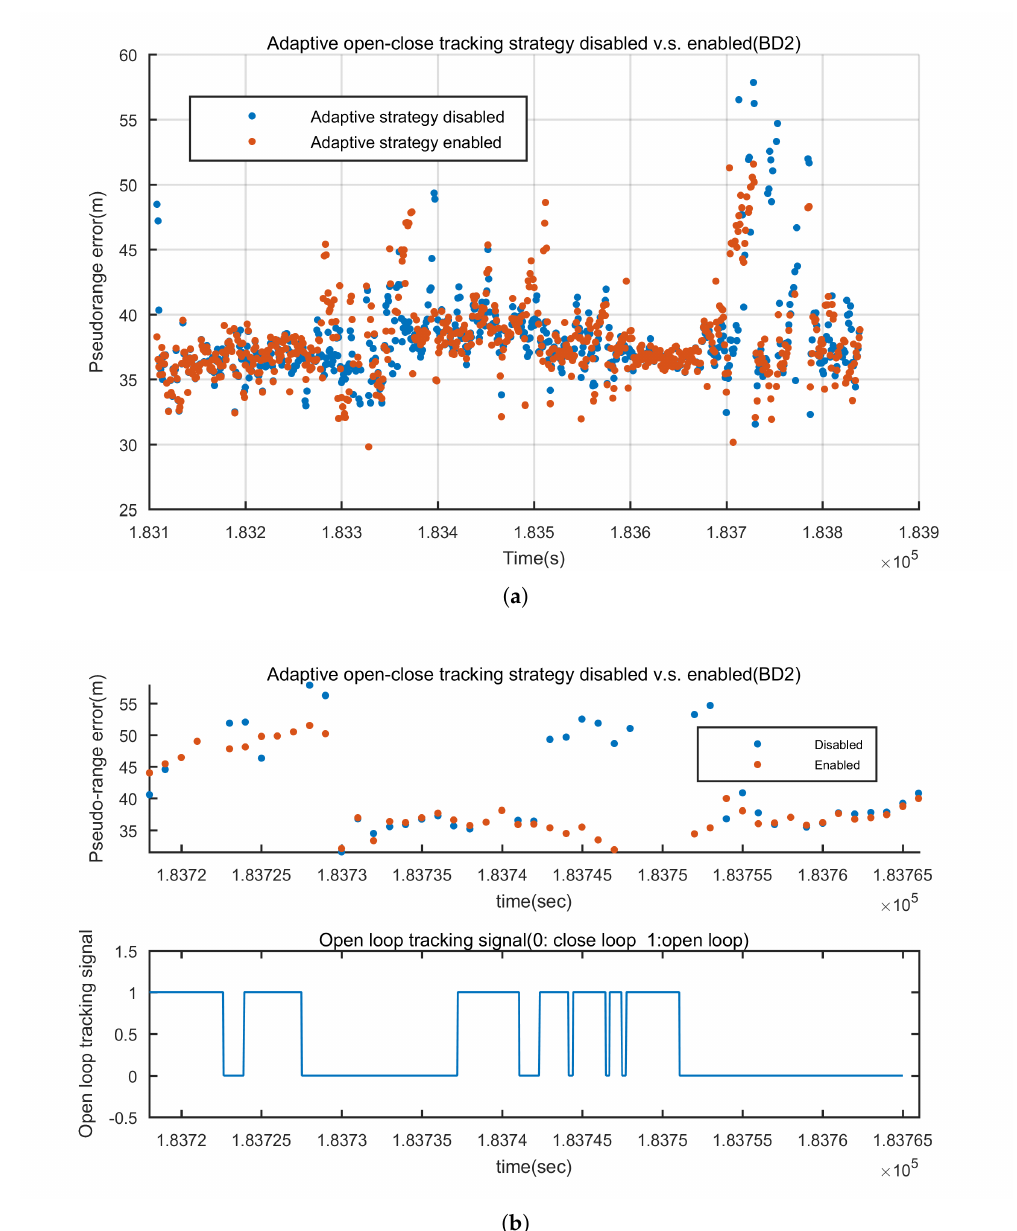
Figure 15. Pseudo-range error before and after applying the adaptive open-close loop tracking strategy of BD 2 ( a ) Pseudo-range error during the whole experiment ( b ) From 183,720 s to 183,760 s, GNSS signals are frequently blocked and the adaptive open-close loops presented better